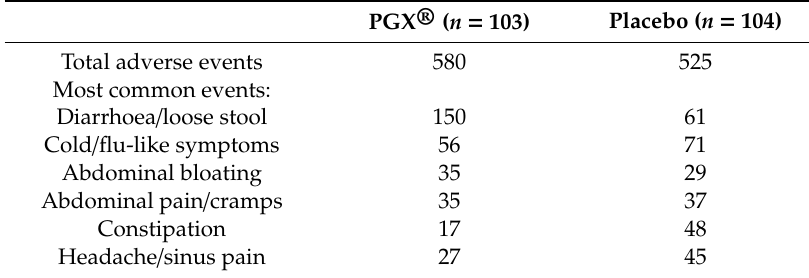
Table 4. The most common adverse events reported over 52 weeks in participants allocated to PGX ® or placebo.